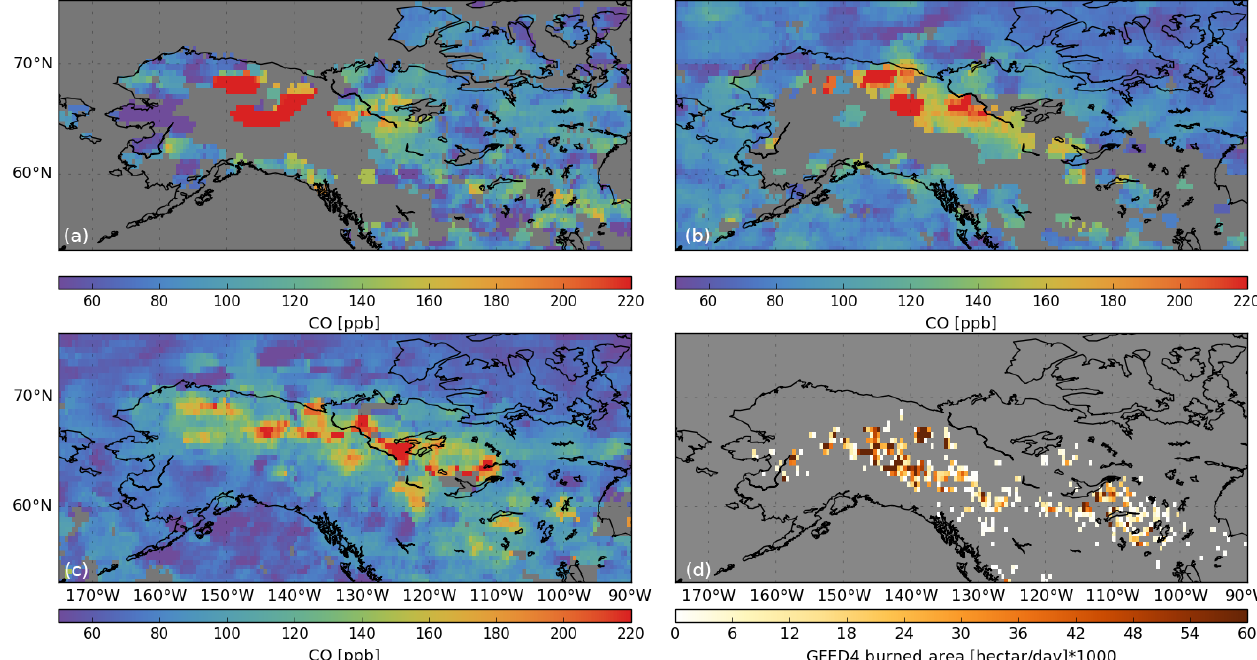
Figure 5. Same as Fig. 3 but for Alaska–Canada. The data are averaged from 1 July to 1 August 2004.